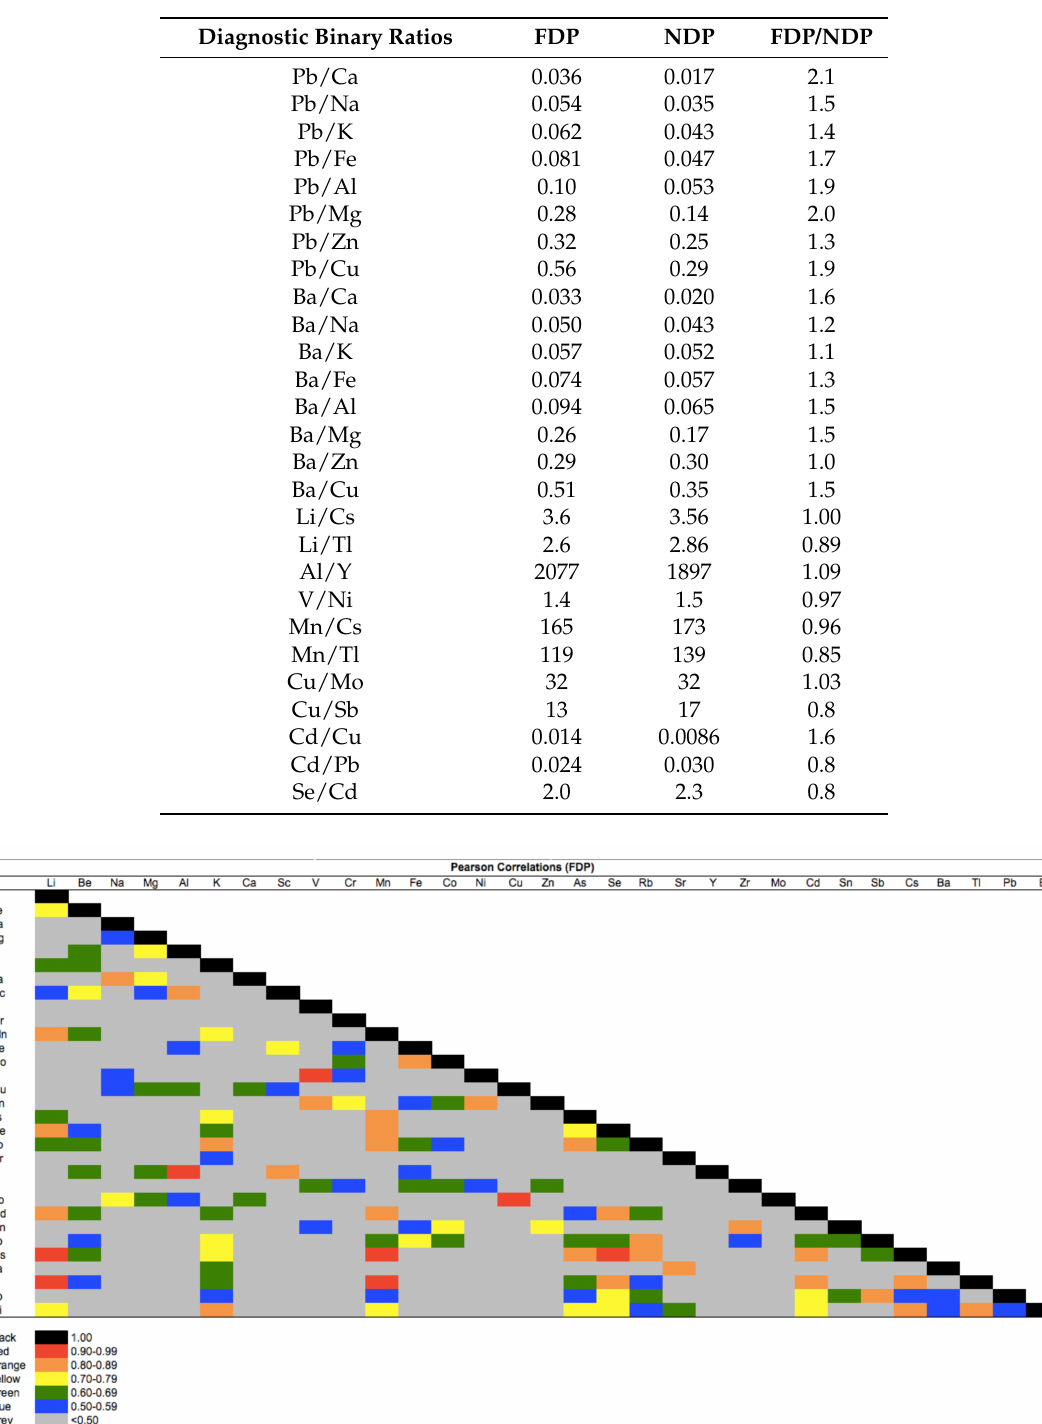
Table 2. Mean ratios of selected metals representative of FDP and NDP.